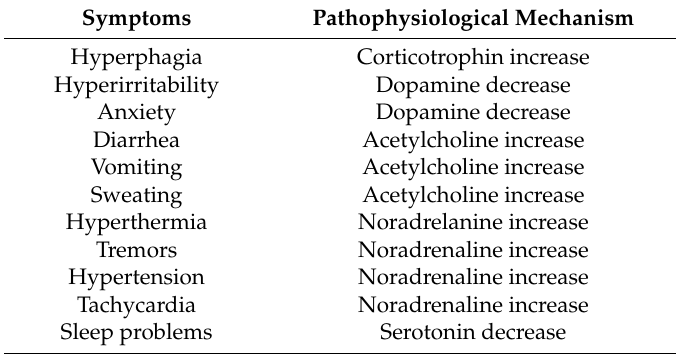
Symptoms associated with Neonatal Abstinence Syndrome (NAS) and associated neurotransmitter changes. Symptoms Pathophysiological Mechanism Hyperphagia Corticotrophin